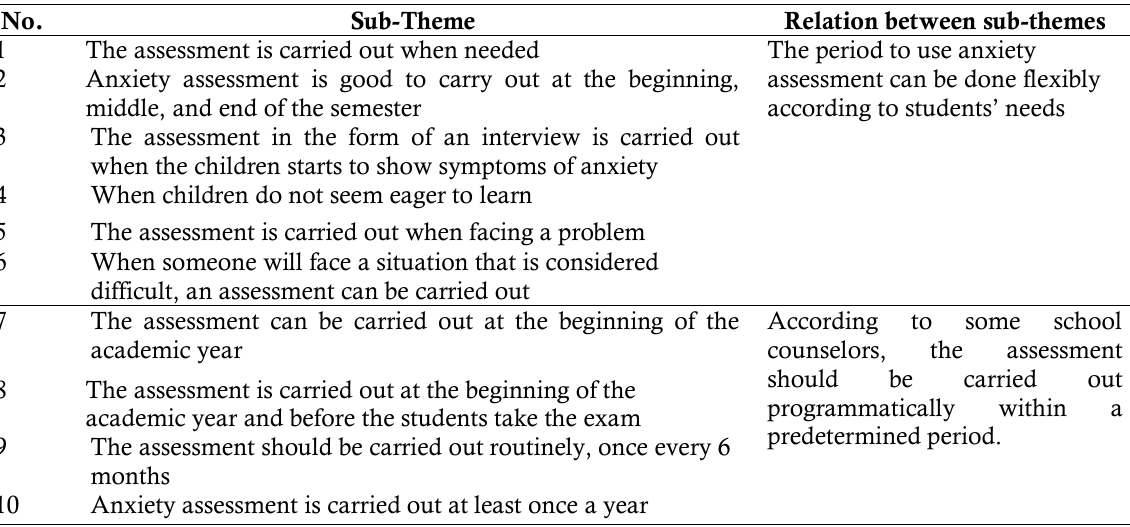
Table 3. The results of reduction regarding the use of anxiety